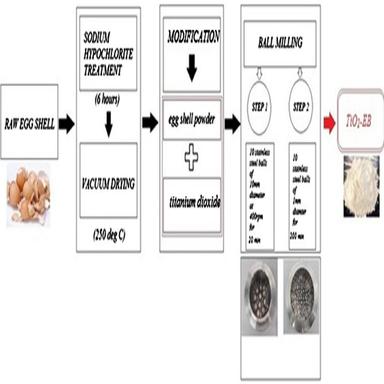
Schematic illustration of different steps in the preparation of TiO2-EB.